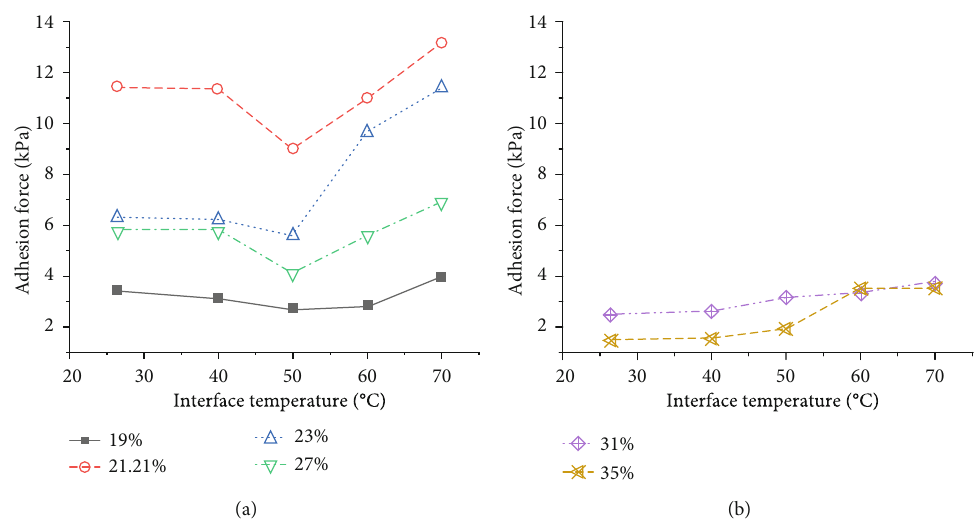
Figure 5: The in fl uence of interface temperature on adhesion force: (a) relative low moisture; (b) relative high moisture.